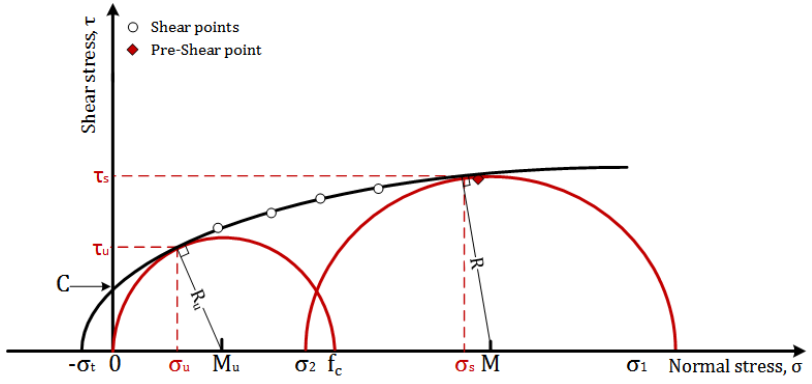
Figure 2. General curved YL and flow properties according to Warren–Spring equation.